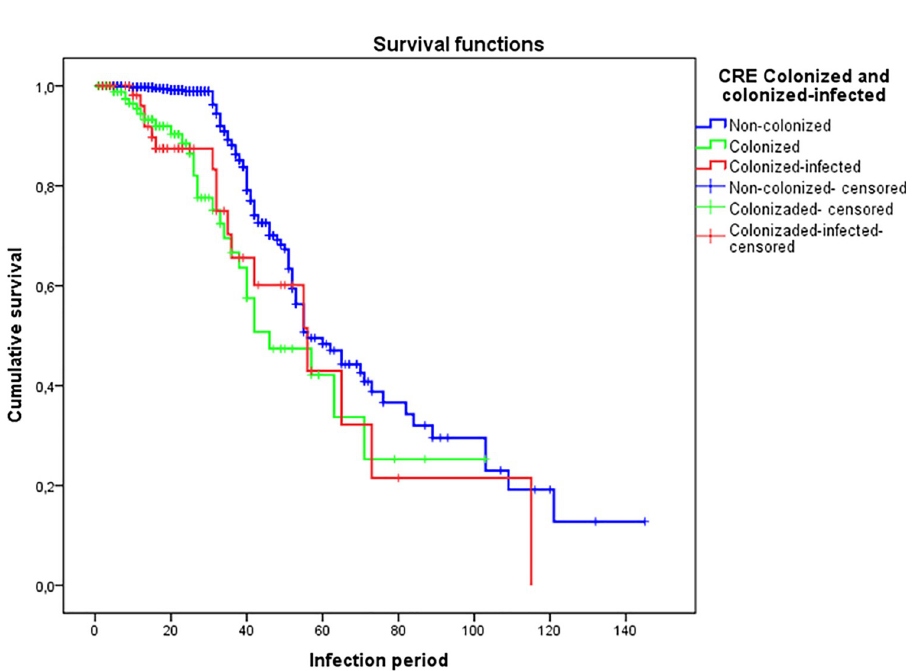
Fig 4. Kaplan-Meier curves of estimated survival of colonized and colonized-infected patients compared with controls.